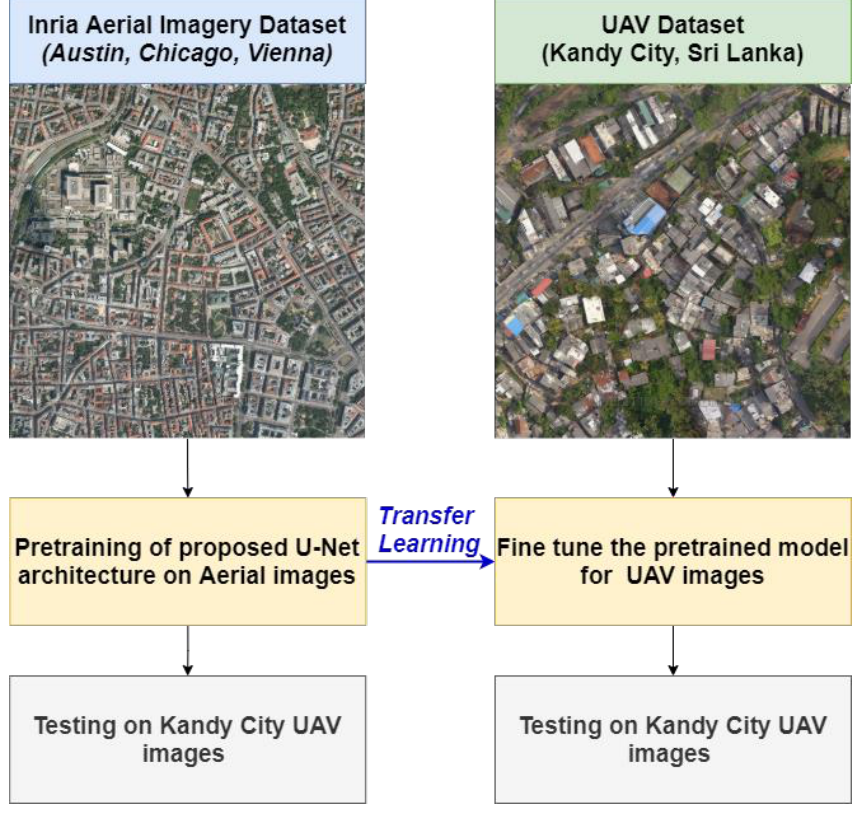
Figure 5. Proposed transfer learning approach for building extraction from UAV data.